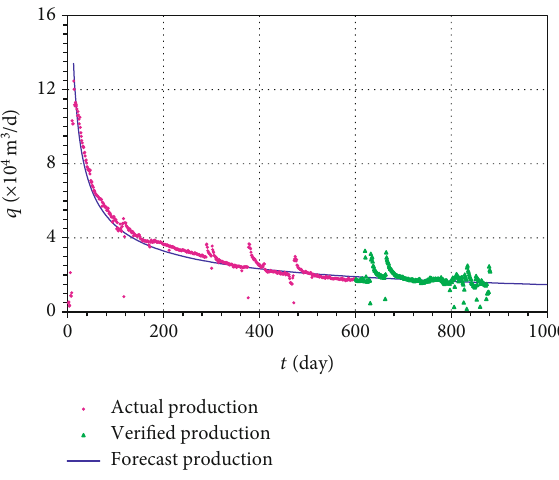
Figure 12: q vs. t matching plot for D well. g